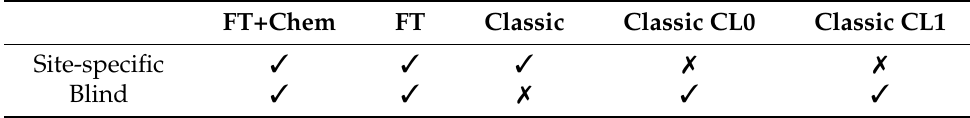
Table 1. Docking protocols employed in the PDBbind benchmarking studies (header) and the conditions with which they were tested (index row). CL, cluster; X, impossible